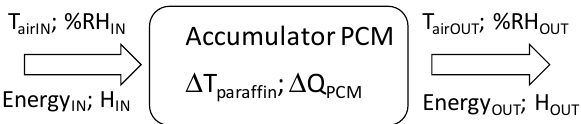
Figure 8. Parameters at the input and output of the PCM accumulator.